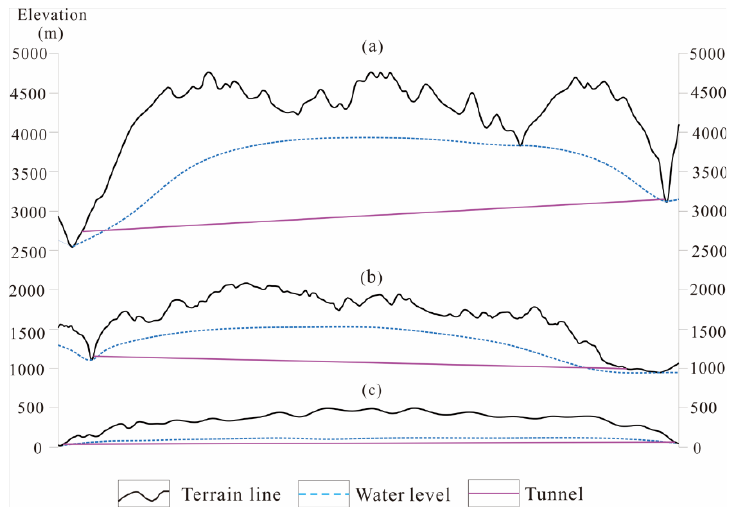
Figure 14. Relationship between tunnel, terrain and groundwater level in three grades. (a) Third grade; (b) second grade; (c) first grade.